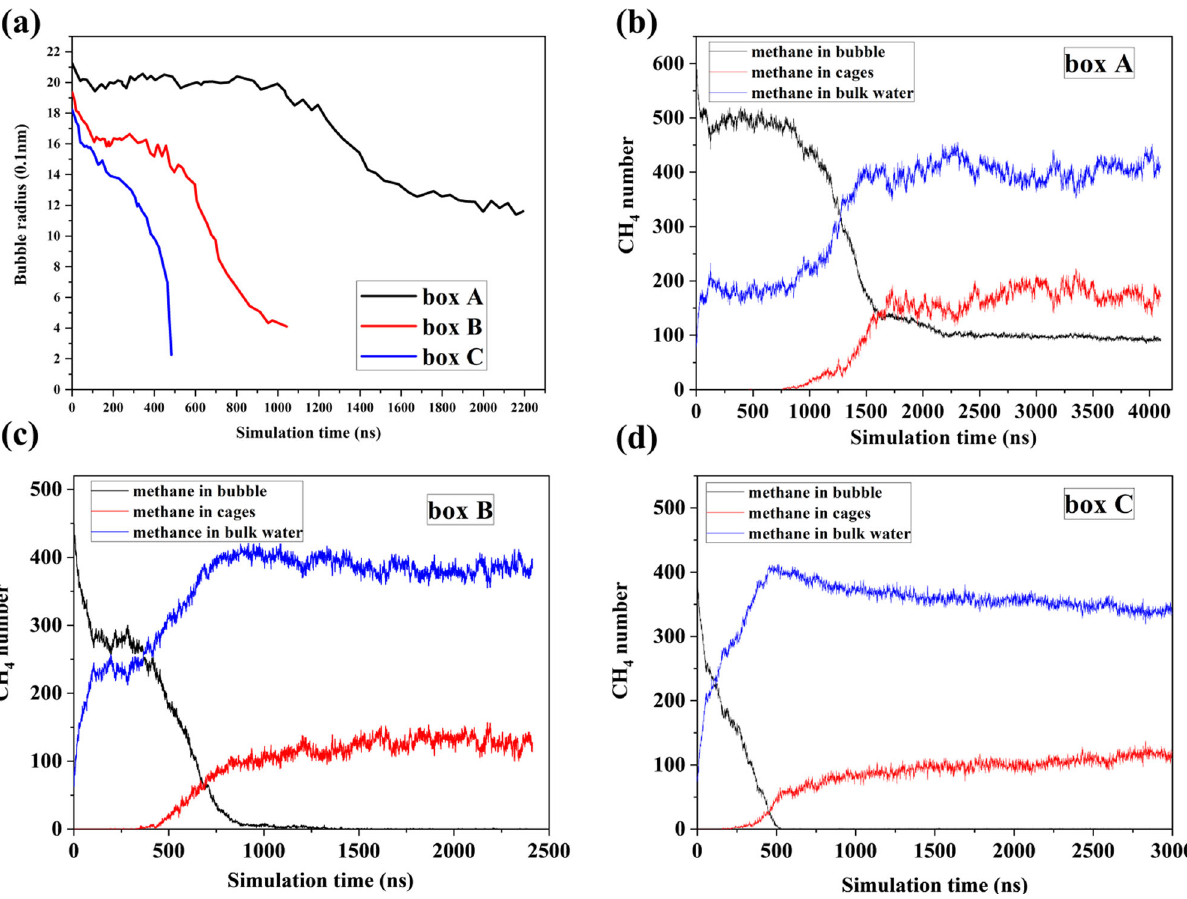
Fig. 2 The evolution of dynamic characteristics in the process of hydrate nucleation for different boxes. a The changes in the bubble radius over time for boxes A – C. b The change in the number of methane molecules in different status for box A. c The change in the number of methane molecules in different status for box B. d The change in the number of methane molecules in different status for box